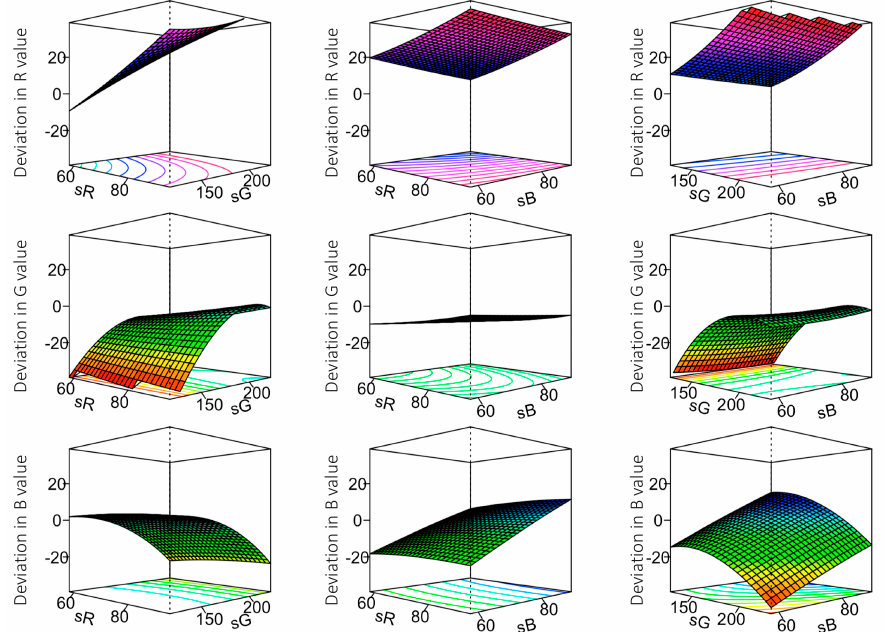
Figure 4. Plots of response surfaces for Case 3 based on the coefficient estimates (raw data are provided in Table A5).